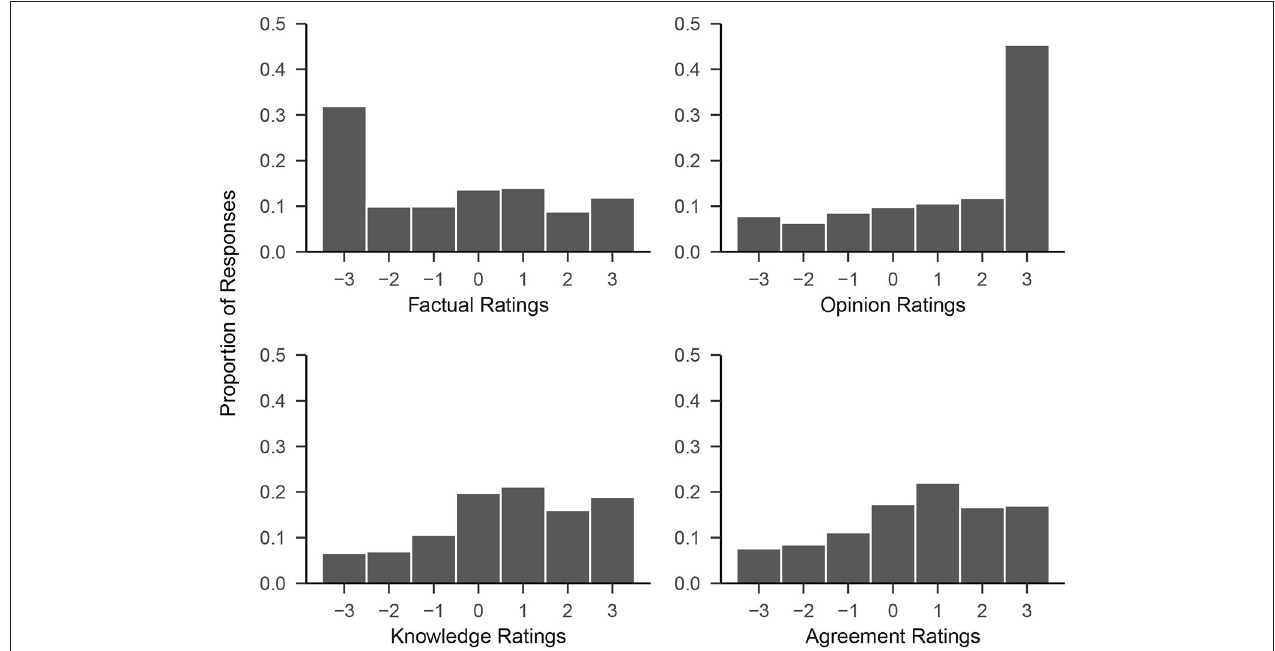
FIGURE 2 | Histograms of responses to all 50 statements across Fact, Opinion, Knowledge, and Agreement rating scales in Study 1. Scores of − 3 correspond to the labels “This is not a fact,” “This is not an opinion,” “I know very little about this topic,” and “I completely disagree,” respectively. Scores of +3 correspond to the labels “This is a fact,” “This is an opinion,” and “I know a lot about this topic,” and “I completely agree.” Intermediate scale points were not verbally